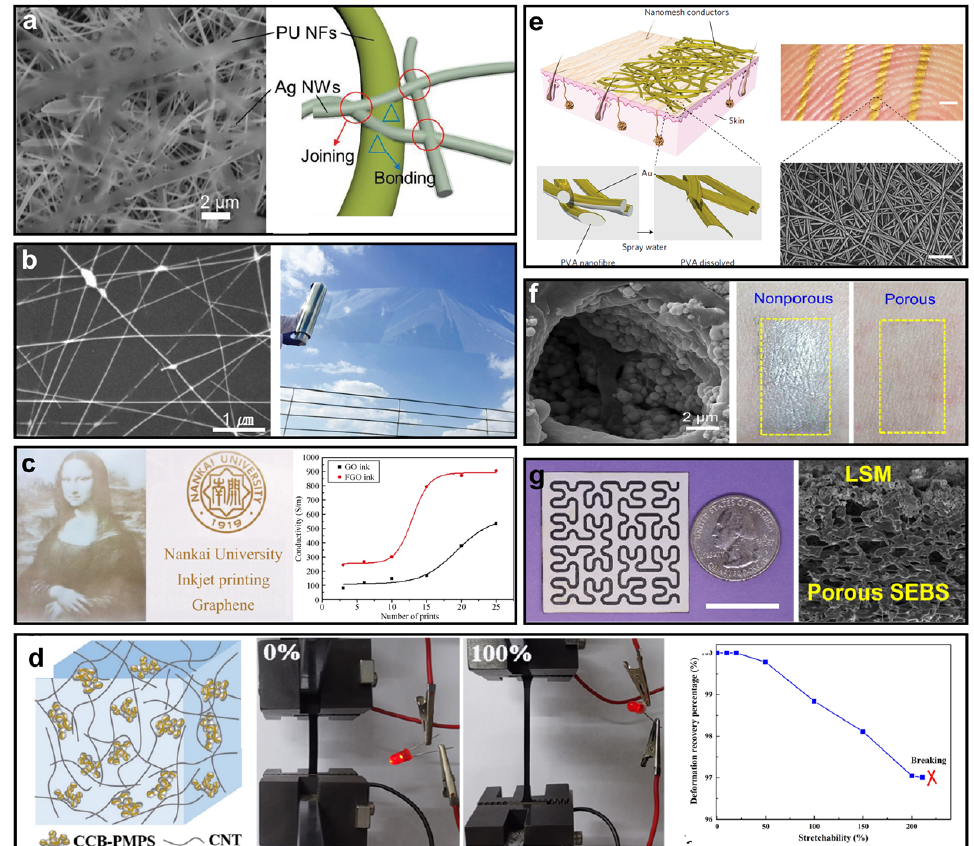
Figure 4. ( a ) Microscopic photograph and diagram of the conducting network of Ag NWs and PU NFs (reprinted with permission from Ref. [58], Copyright 2019 John Wiley & Sons, Inc.). ( b ) Microscopic photograph of Ag NWs/PEDOT:PSS and its transparent nature (reprinted with permission from Ref. [59], Copyright 2015 Royal Society of Chemistry). ( c ) Graphene nanoink-fabricated patterns and their conductivity (reprinted with permission from Ref. [60], Copyright 2011 Springer Nature). ( d ) Structure of the carbon nanotube–propyl methacrylate–conductive-carbon back (CNT-PMPS-CCB), a demonstration of its stretchability, and its recovery rate under different stretchability conditions (reprinted with permission from Ref. [61], Copyright 2020 Elsevier Ltd.). ( e ) Diagram of Au nanomeshes, photographs of the conductor attached to the epidermis, and an SEM image (re- printed with permission from Ref. [62], Copyright 2017 Springer Nature). ( f ) Porous liquid metal in under a microscope and comparison of liquid leakage between the porous and nonporous liquid metal (reprinted with permission from Ref. [63], Copyright 2023 The American Association for the Advancement of Science). ( g ) MoO 2 -enabled Hilbert serpentine pattern and its SEM image (re- printed with permission from Ref. [64], Copyright 2022 The American Association for the Advance- ment of Science).